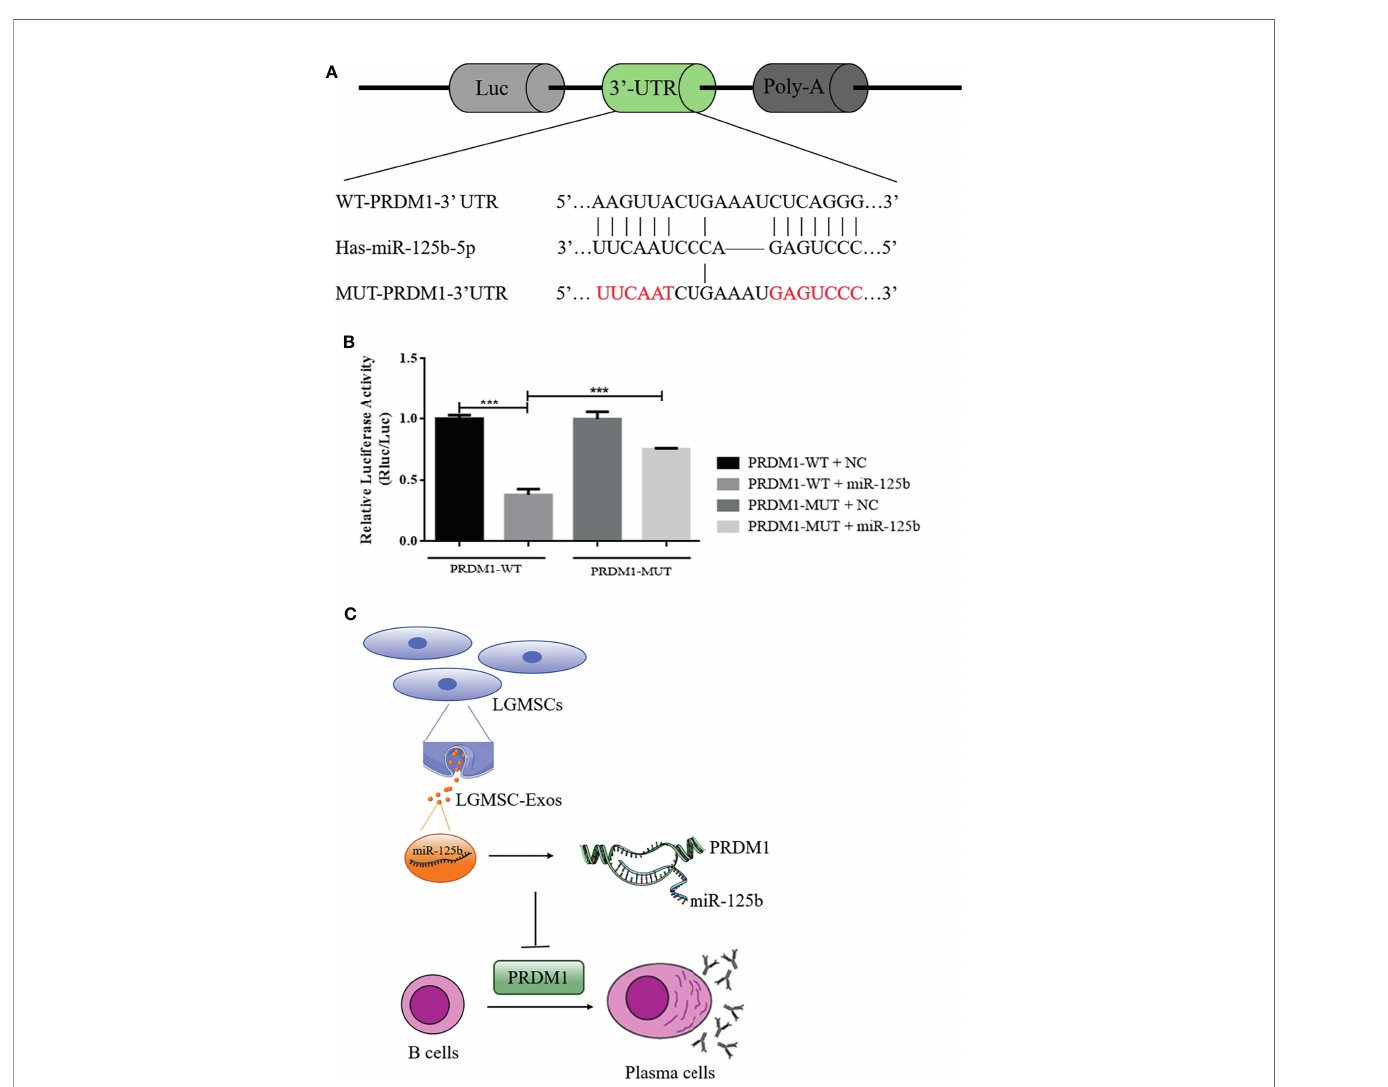
FIGURE 7 | PRDM1 is a direct target of miR-125b and the putative mechanism of LGMSC-Exos on plasma cells. (A) The seed sequence of miR-125b located in the PRDM1 wild-type 3 ′ -UTR and the mutated sequence. (B) Luciferase activities after co-transfection of miR-125b and the PRDM1 wild-type 3 ′ -UTR and mutant 3 ′ -UTR. Data represent the mean ± standard deviation (SD; n = 3 independent experiments). ***p < 0.001. (C) Putative mechanism of LGMSC-Exos on plasma cells involving miR-125b and